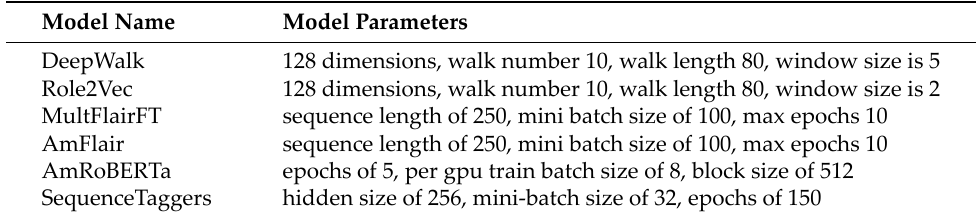
Table 2. Training parameters for the different semantic models and NLP applications.